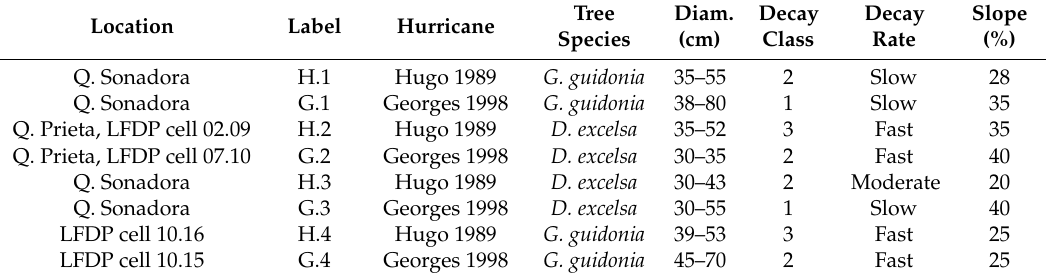
Table 2. Characteristics of logs that were used in this study. The label is comprised of the first letter of the hurricane that felled the tree, followed by the block number. Tree species were Guarea guidonia (Meliaceae) and Dacryodes excelsa (Burseraceae) but tree species were found to be similar and were not part of the model. Decay class was rated based on description of the logs were selected for study according to the classification of Torres (1994) [38]. Decay rate was classified 18 and 27 years after Hurricane Georges and Hugo, respectively: slow—retaining some bark, diameter loss less than 5 cm; moderate—no bark remaining, diameter loss more than 5 cm but wood remaining; fast—either in the form of a mound of humus invaded by roots or no visible remains). Slope (%) was measured where the logs were